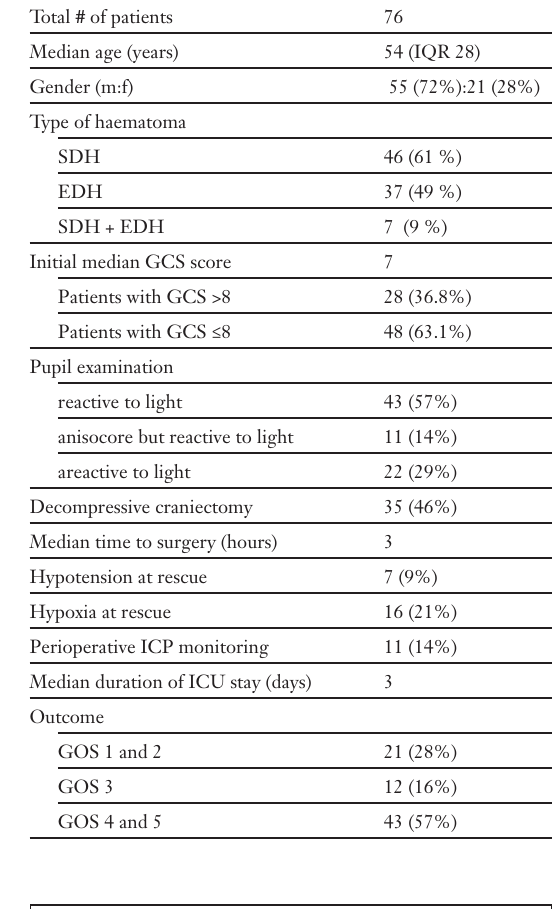
Documenting the association of age with overall outcome, showing a clear decline in age with improved outcome.